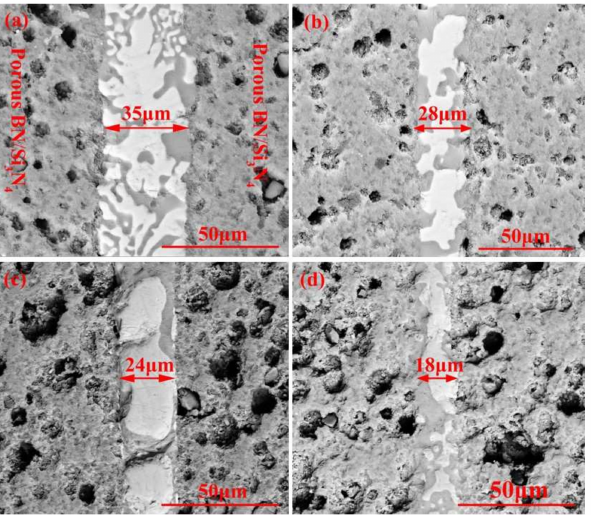
Figure 4. SEM micrographs showing reference welded joint brazed with SiCo38 alloy for 10 min